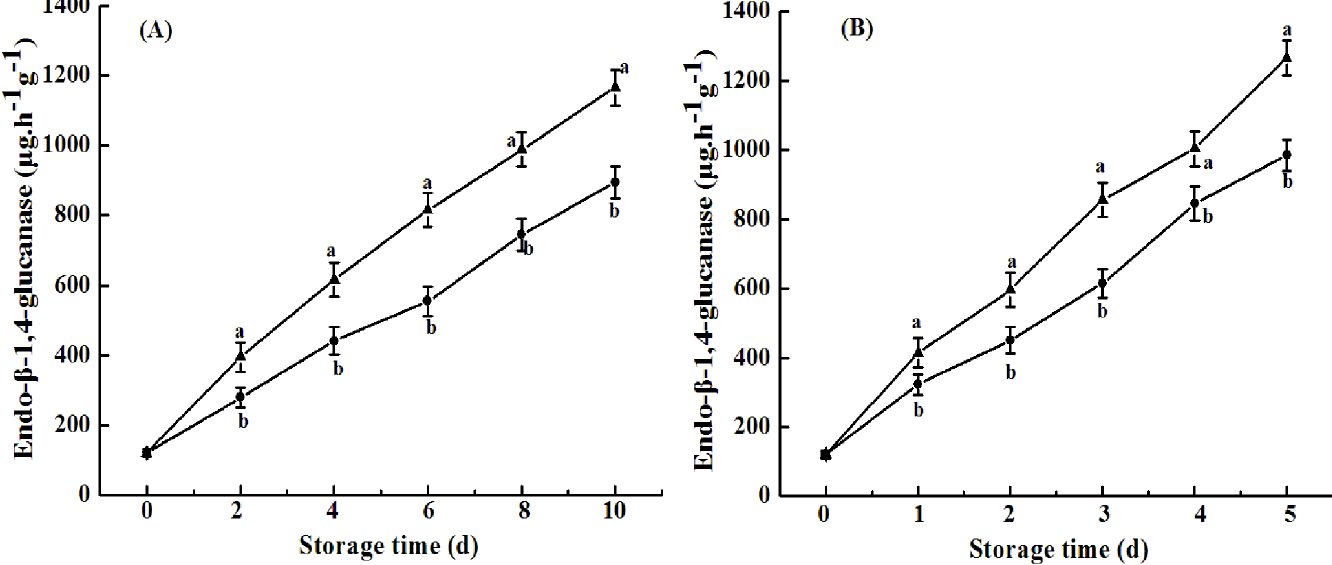
Fig 7. Endo- β -1,4-glucanase activity of avocado fruits upon natural (A) or ethylene-induced (B) ripening with ( ● ) or without ( ▲ ) cold shock treatment (CST) during 10- or 5-day storage at 20˚C and 85–90%RH. Vertical bars representthe standard error of three replicates. Different letters at any storage time indicate significantdifferences (P <